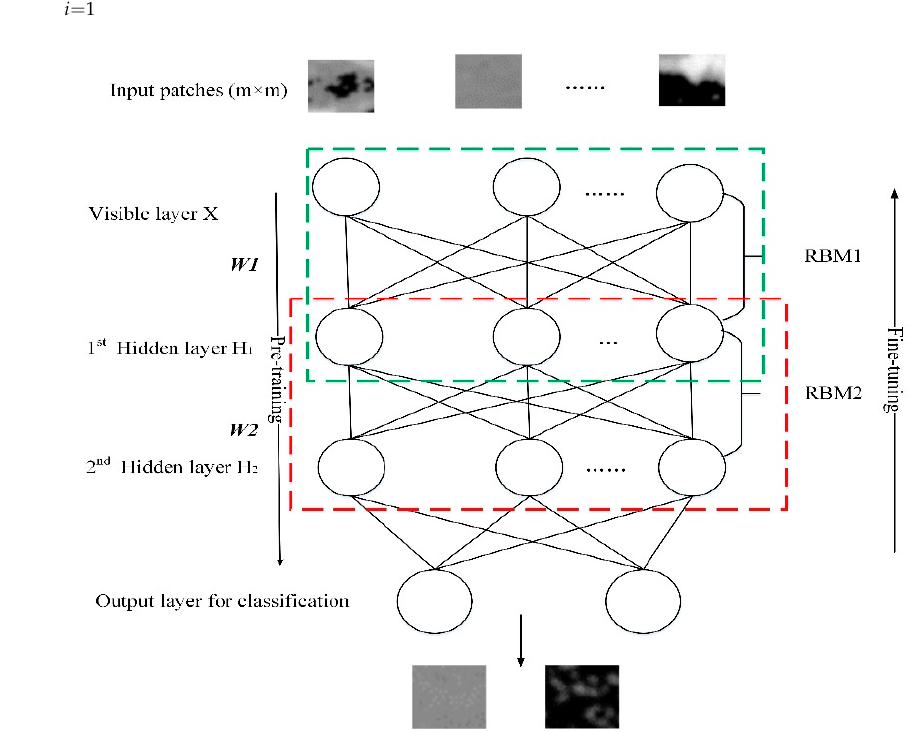
Figure 5. The structure of the proposed PaDBN Model.